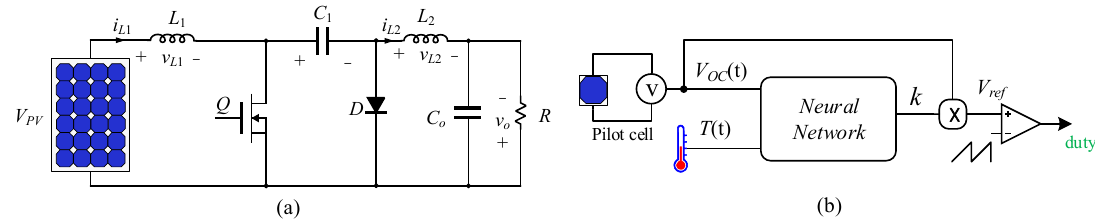
Figure 12. The experimental setup: ( a ) ´Cuk converter ( b ) the proposed controller.